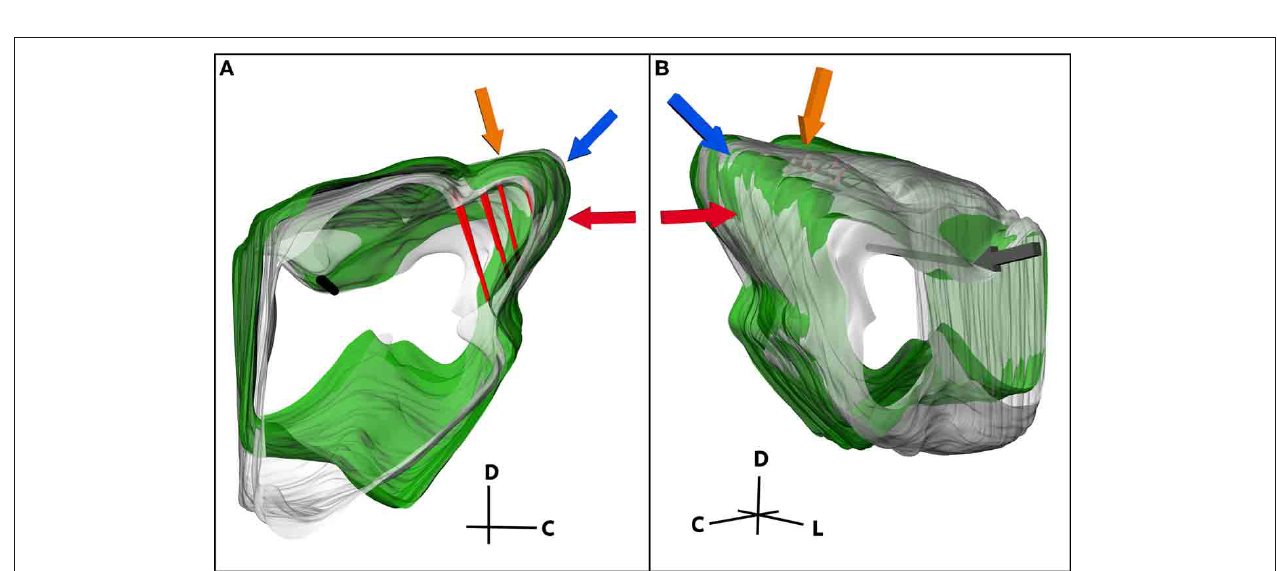
FIGURE 7 | (A) Medial and (B) lateral views of two midbrains (green and gray) normalized to each other. The consistent reference track is shown in black and three pairs of electrode tracks in red. Three of the landmarks used to normalize the midbrains are highlighted, including the caudal-dorsal surface of the inferior colliculus (IC; blue arrow), the curvature of the IC